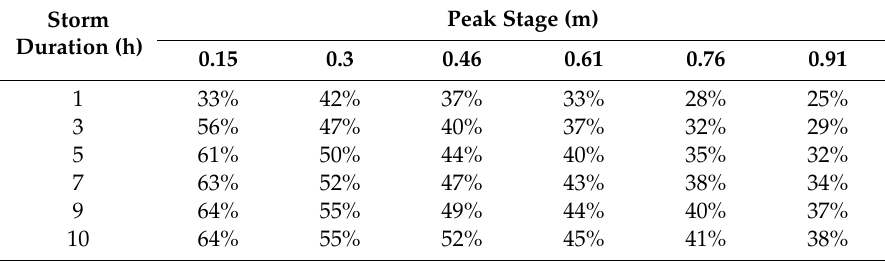
Table 2. Percentage of bank storage remaining at 100 h (% = volume at 100 / maximum bank storage).